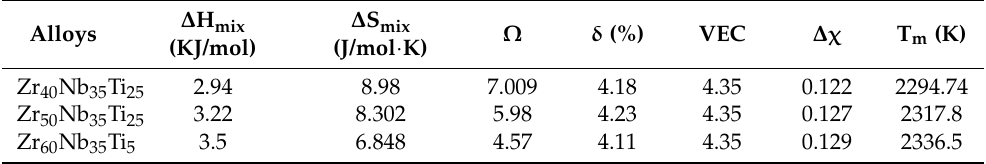
Table 3. Calculation of relevant parameters of the Zr 40 Nb 35 Ti 25, Zr 50 Nb 35 Ti 15 , and Zr 60 Nb 35 Ti 5 high-entropy